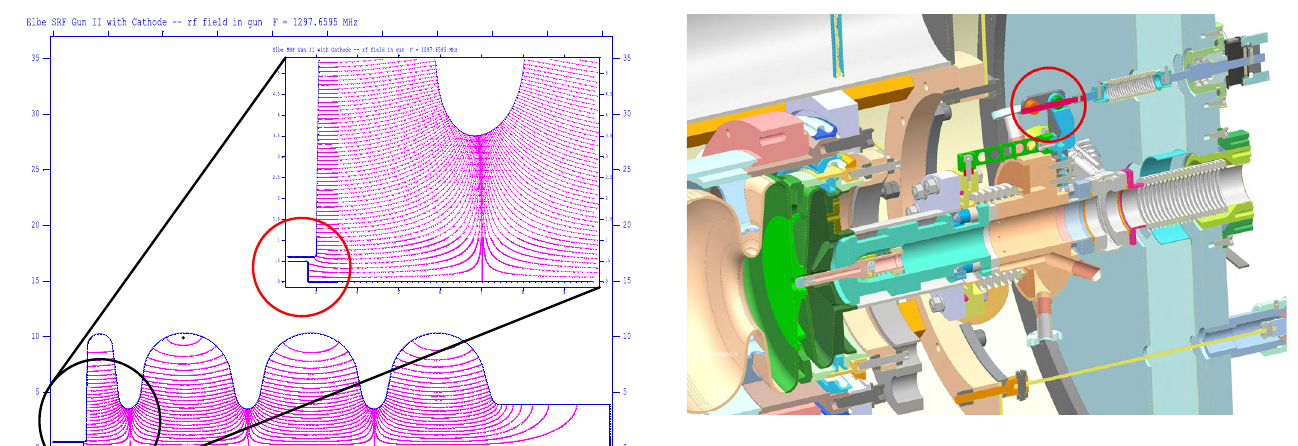
FIG. 3. CAD image for the cathode tuner, half cell (green) of the resonator and the cathode cooler inside the gun cryostat. The indicated mechanism connects the cathode cooler/holder to a gear outside the cryostat, making it possible to move the cathode tip in and out of the resonator during operation. The green bridge left and below of the highlighted area is, besides the mechanical connection, also responsible for the thermal decoupling of the cathode cooler and